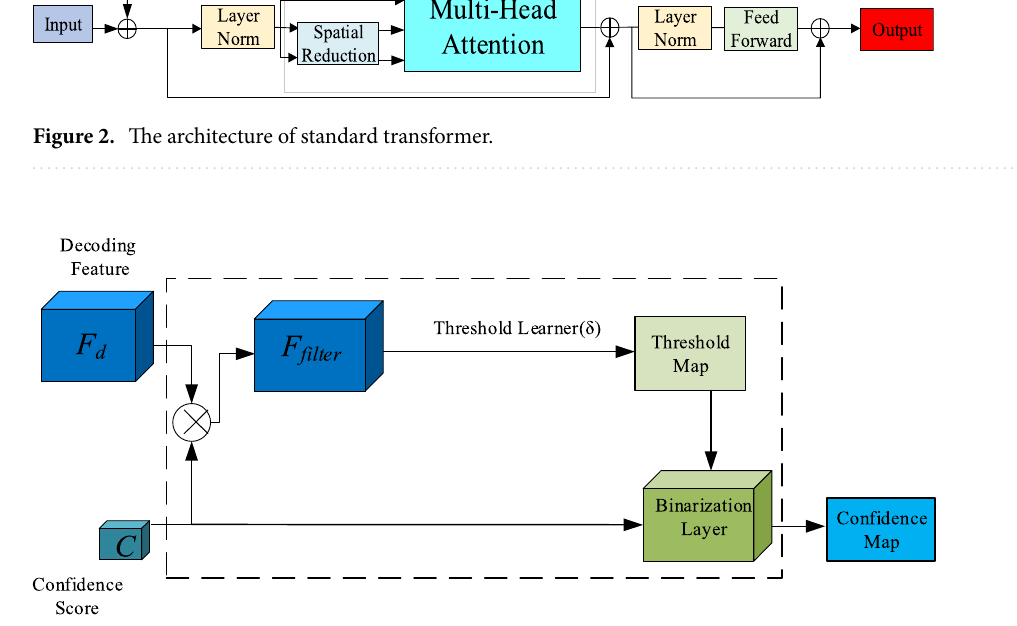
Figure 3. The Flowchart of Binarization Module. The attention filter is a dot product operation between the decoding feature F d and predicted confidence map